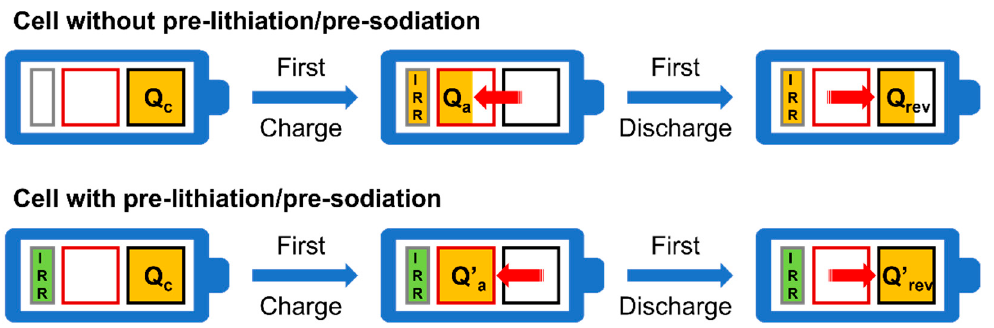
Figure 1. Schematic drawing illustrating how the reversible capacity changes in cells without and with prelithiation/presodiation during the formation cycle. Q c : initial cathode specific capacity; Q a and Q’ a : available anode capacity after the first charge; Q rev and Q’ rev : reversible capacity after the first discharge.